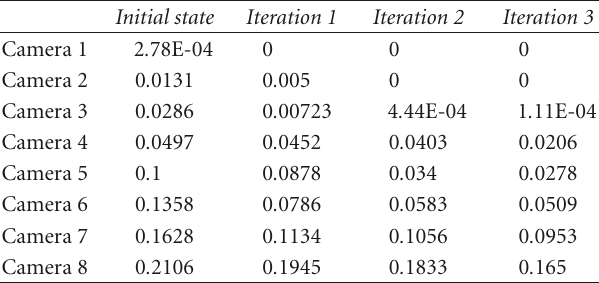
Table 6: Mis Err t i rates during incremental learning initial train- ing set = 14400.